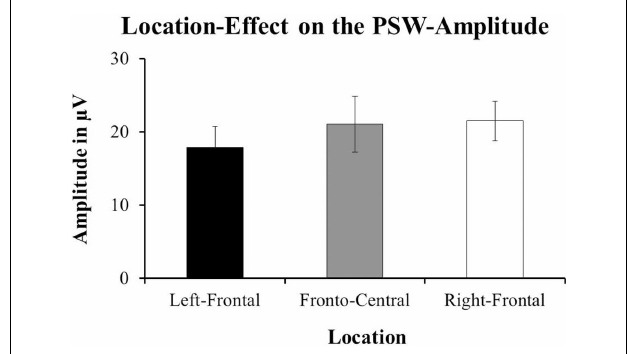
FIGURE 7 |The data from our group of 1-year-olds showed a tendency toward an effect of Location on the amplitude of the Positive slow-wave [PSW; F (1, 13) = 3.11, p = 0.061]. The right-frontal channel-group (F4, FC6, and C4; ± SE) had more positive amplitudes compared to the fronto-central channel-group (Fz and Cz; ± SE) and the left-frontal channel-group (F3, FC5, and C3; ± SE).